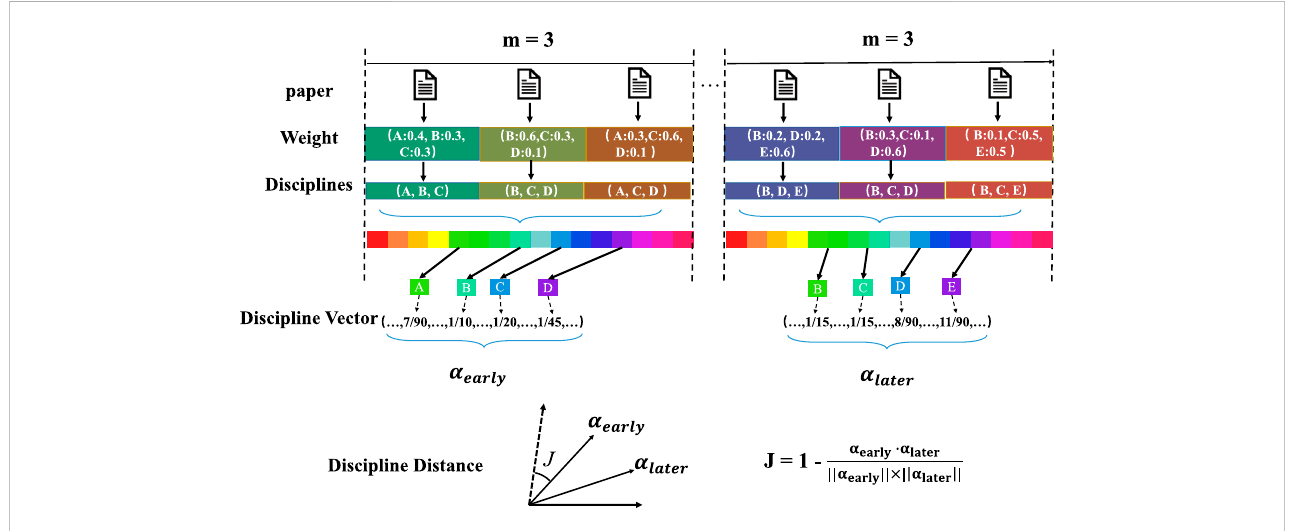
FIGURE 1 An example to calculate the interdisciplinary distance J ( m = 3). The early careers ’ discipline vector α early and the later careers ’ discipline vector α later are generated based on the early and later m papers. Finally, the interdisciplinary distance J is measured according to the complementary cosine similarity between discipline